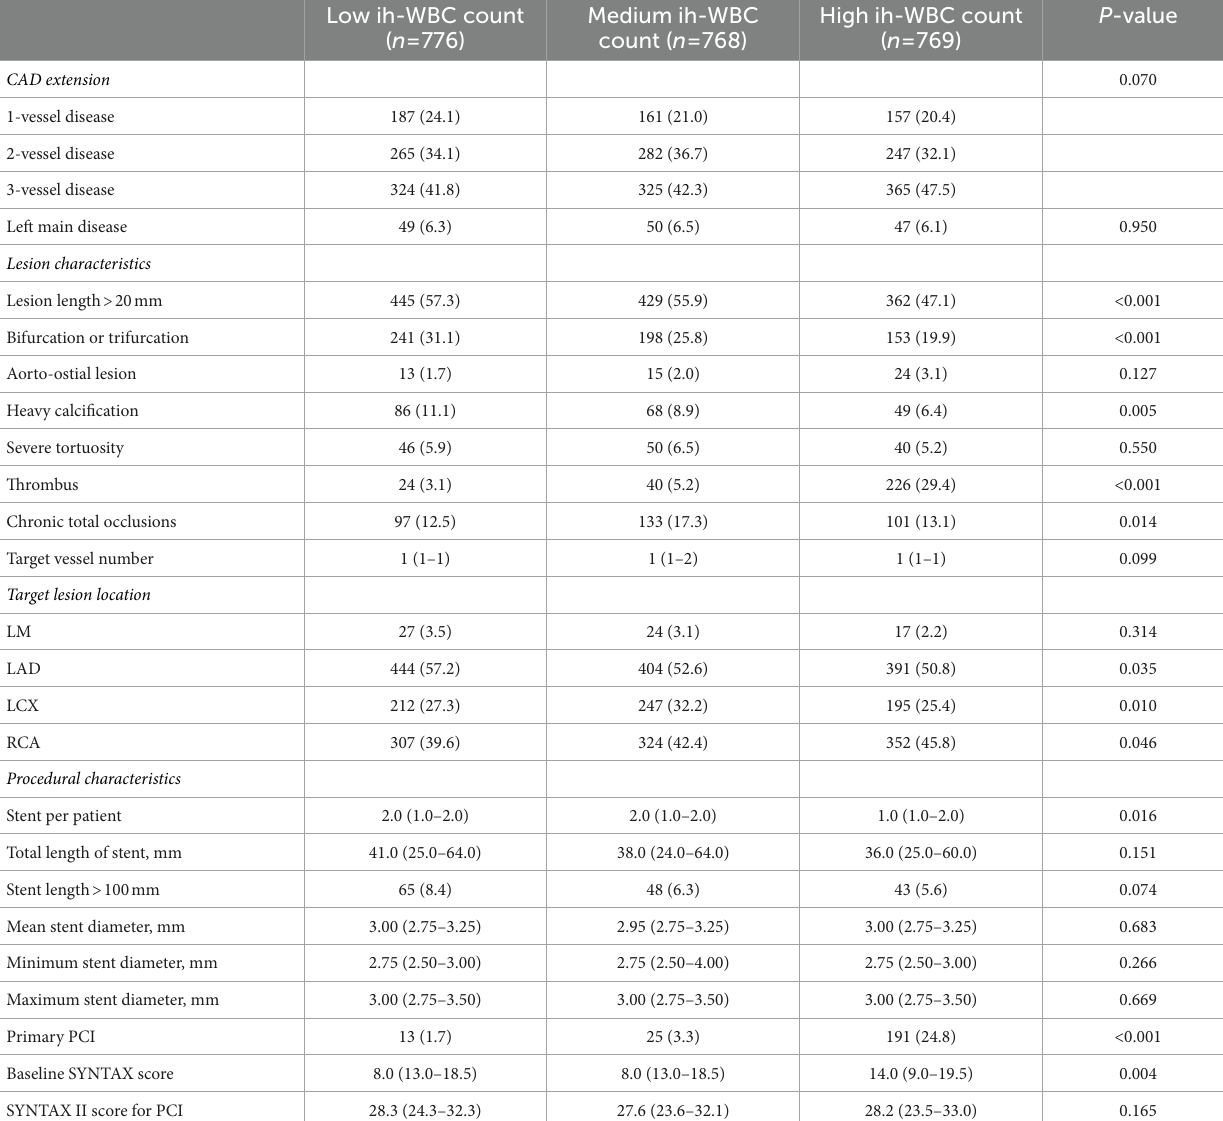
TABLE 2 Anatomical characteristics of lesions and procedural